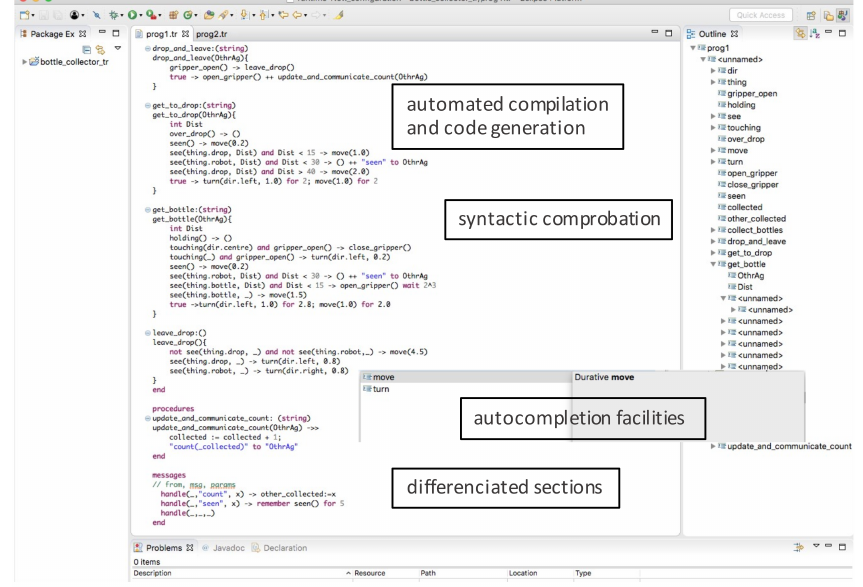
Figure 5. TR program editor implemented using Eclipse, Xtext and